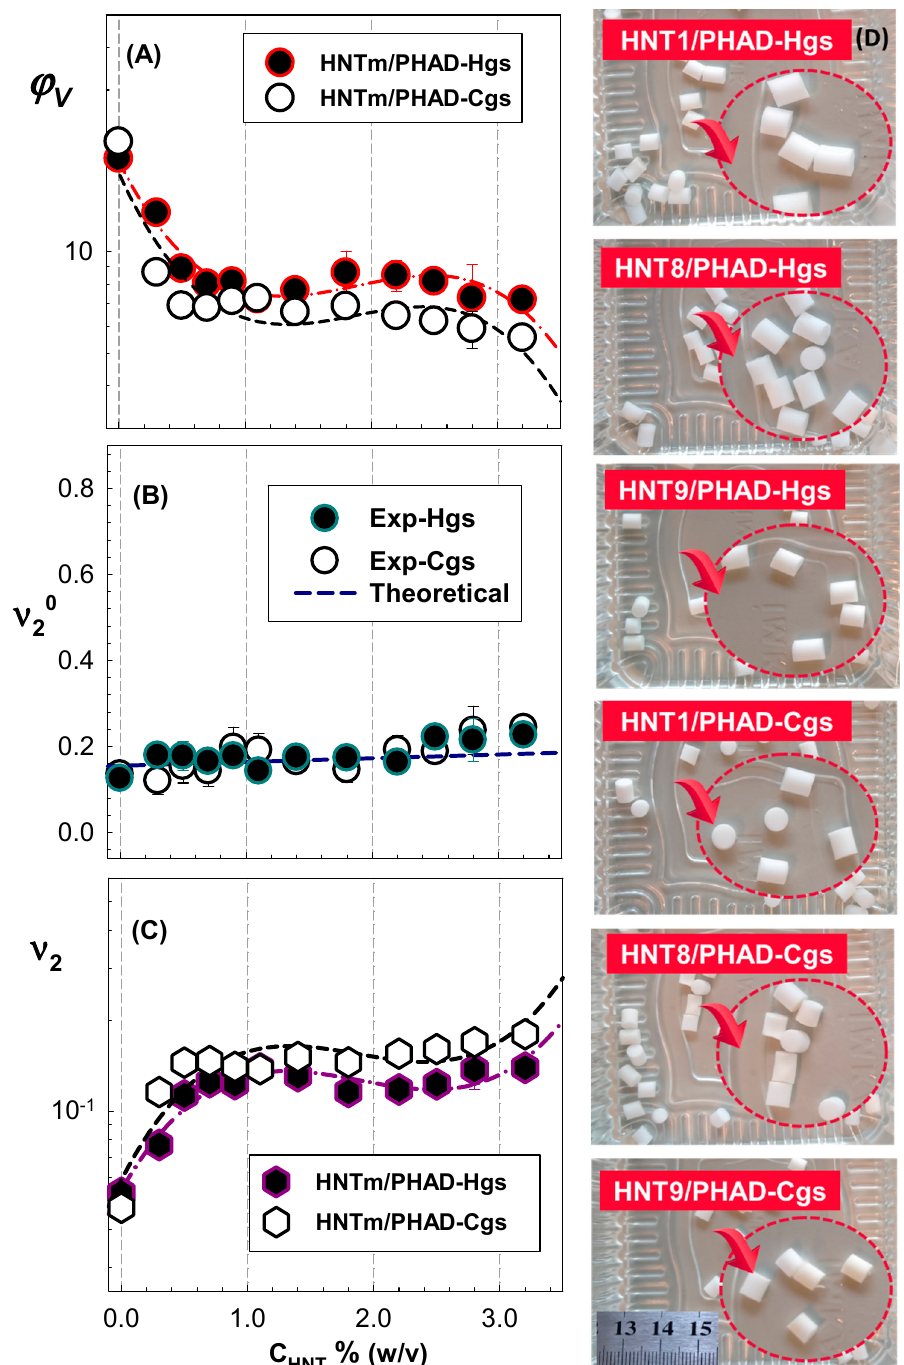
ϕ Figure 8. The volume degree of swelling ϕ V ( A ). The experimentally determined values of volume Figure 8. The volume degree of swelling V ( A ). The experimentally determined values of volume fraction of cross- fraction of crosslinked terpolymer network as-prepared state ν 0 ( B ) and in the equilibrium swollen 2 0 ν ν ternary hybrid network ν ( C ) of ternary hybrid HNTm/PHAD-Hgs and -Cgs as a function of HNT ( B ) and in the equilibrium swollen ternary hybrid network 2 ( C ) of linked terpolymer network as-prepared state 2 2 concentration. ( D ) Optical appearance of HNTm/PHAD-Hgs and -Cgs containing 0.30%, 2.20%, and ternary hybrid HNTm/PHAD-Hgs and -Cgs as a function of HNT concentration. ( D ) Optical appearance of 2.5% ( w/v ) of HNT after attaining equilibrium swelling in HNTm/PHAD-Hgs and -Cgs containing 0.30%, 2.20%, and 2.5% ( w/v ) of HNT after attaining equilibrium swelling in wa- ter.